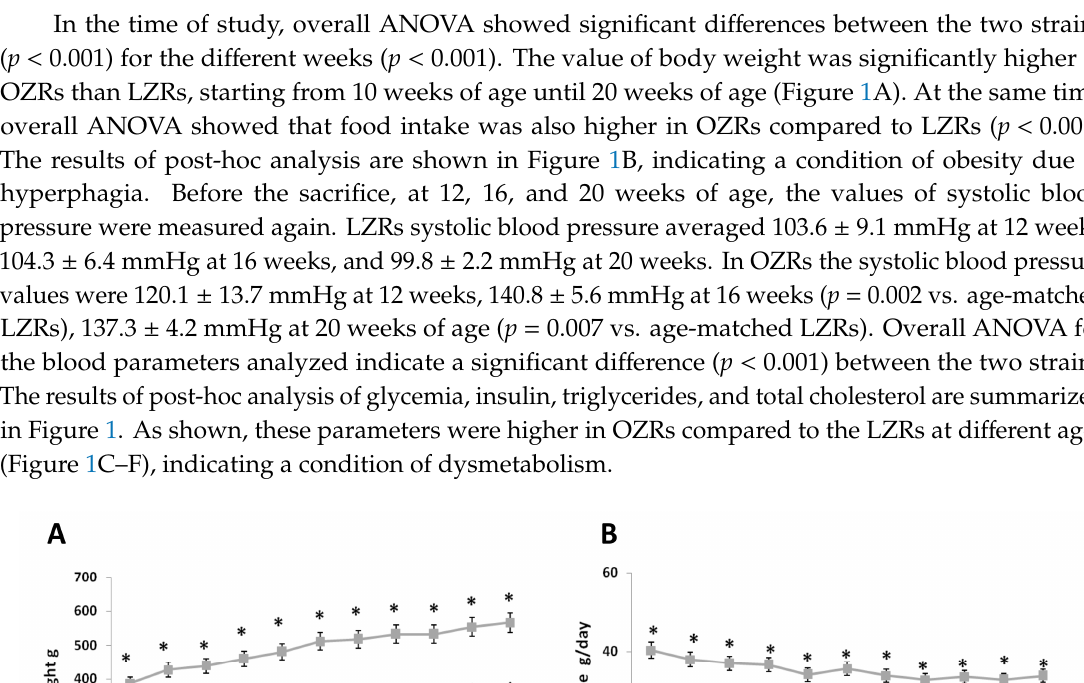
Figure 1. General and blood parameters. Body weight ( A ), food intake ( B ) starting from 10th week of age (first week of housing) to 20th week of age (last sacrifice) for lean Zucker rats (LZR) and obese Zucker rats (OZR). Plasma levels of glucose ( C ), insulin ( D ), total cholesterol ( E ), and triglycerides ( F ) for LZRs and OZRs at different ages. Data are the mean ± SEM. * p < 0.05 vs. age-matched LZR. 3.2. Oxidative Stress Conditions in Brain Areas Different oxidative stress markers were analyzed in several brain areas. Lipid peroxidation was evaluated by the TBARS kit that represents a well-established method for screening the levels of malondialdehyde (MDA) as a naturally occurring product of lipid peroxidation [36,37]. Overall ANOVA showed a difference in TBARS concentration between the two strains in the frontal cortex ( p = 0.008) but not in the hippocampus ( p = 0.985) as shown in Figure 2. Post-hoc analysis revealed that TBARS concentration in the frontal cortex was higher in 12 and 20 weeks-old OZRs compared to age-matched LZRs (Figure 2A), while in the hippocampus no differences were present between obese and lean rats in different ages (Figure 2B). In the analysis of the antioxidant enzyme SOD, the overall ANOVA showed a significant difference between the two strains both in the frontal cortex ( p = 0.003) and in the hippocampus ( p = 0.004). SOD specific activity was decreased in frontal cortex and hippocampus of 12 weeks and 16 weeks-old OZR compared to the age-matched LZRs (Figure 2C, Figure 2D). A significant decrease in GPX specific activity was found in OZRs compared to the LZR both in the frontal cortex ( p = 0.004) and in the hippocampus ( p = 0.001) (Figure 2E, Figure 2F).